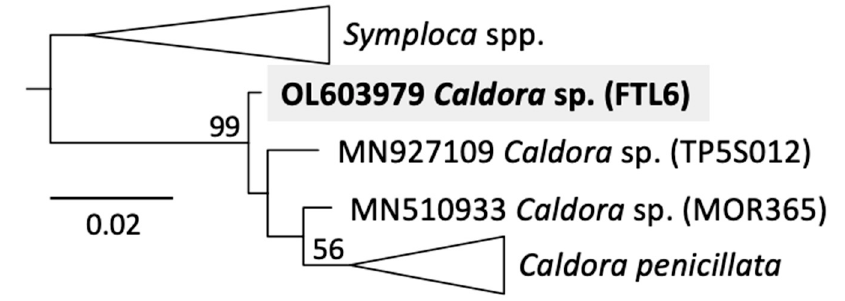
Figure 2. 16S rDNA maximum-likelihood tree showing the early branching phylogenetic position of the sample FTL6 within Caldora spp. The numerous sequences found in the C. penicillata clade, as delimited by Engene et al. [10], are summarized as a triangle for figure clarity (see Supplementary Materials Figure S7 for additional details).